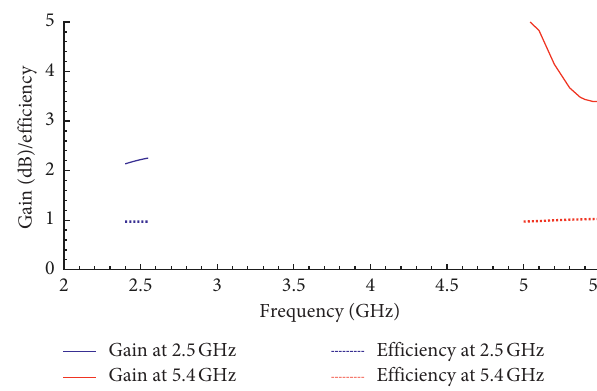
Figure 7: The S 11 of Slotted defected-ground width BioAs-MPAs